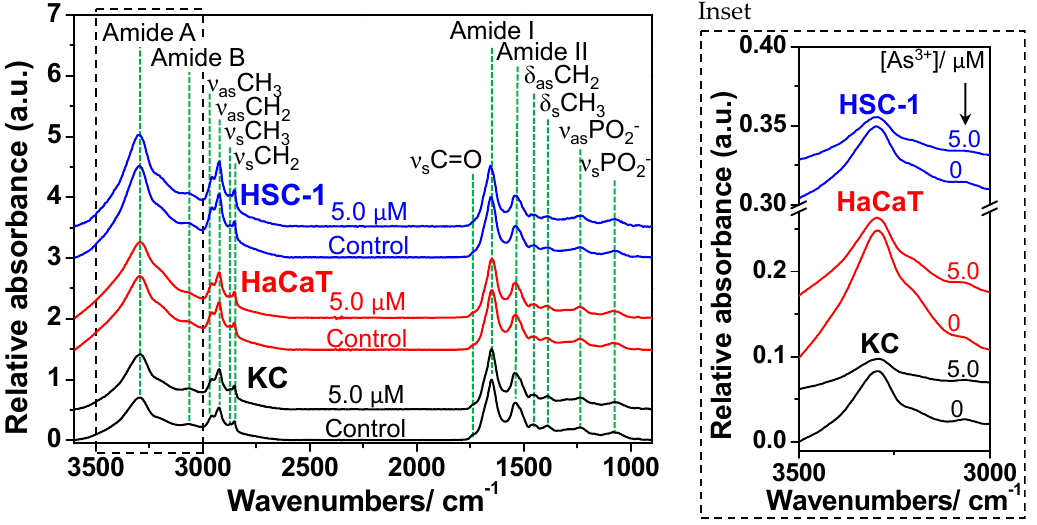
Figure 1. The representative normalized FTIR reflectance spectra of cell samples on low-e slides after arsenite exposure by co-cultured with sodium arsenite (0 and 5 µM) in the range of 3600–900 cm − 1 ; the inset plot showed the amide A band of cell samples without spectral normalization in the range of 3500–3000 cm − 1 . All FTIR reflectance spectra were acquired by using a FTIR spectrometer coupled with an infrared integrating sphere.